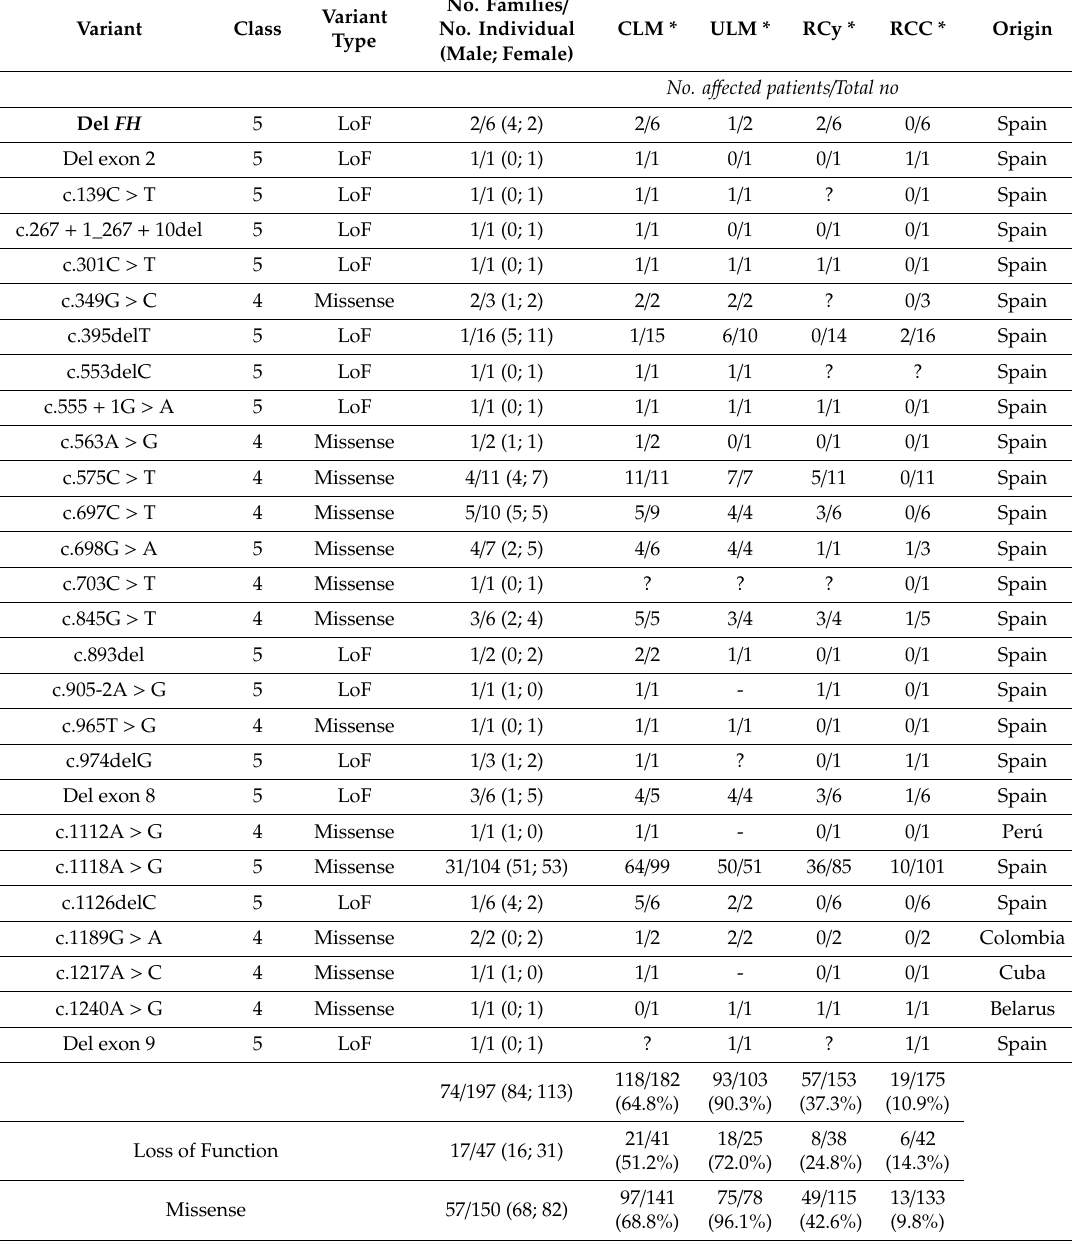
Table 1. Genotype and phenotype characteristics of HLRCC